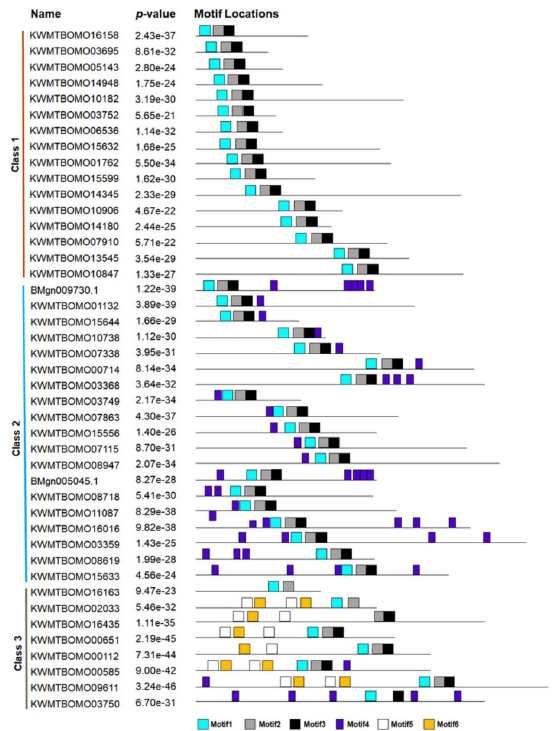
Fig 3. Distribution of conserved motifs of the homeodomain TF family. A total of six conserved motifs were identified in the TFs of the homeodomain family by the online MEME program. The motifs are shown in different colors and numbered 1 to 6. This family was classified into three subgroups based on the motif